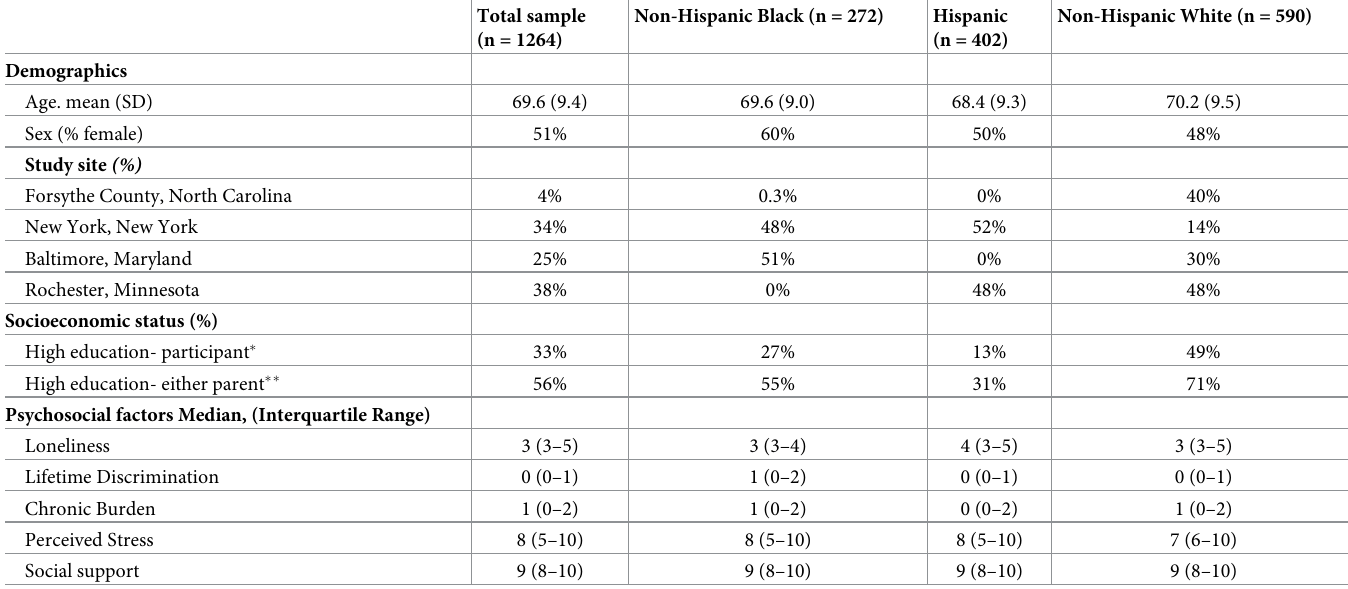
Table 2. Characteristics of the MESA study sample with gene expression